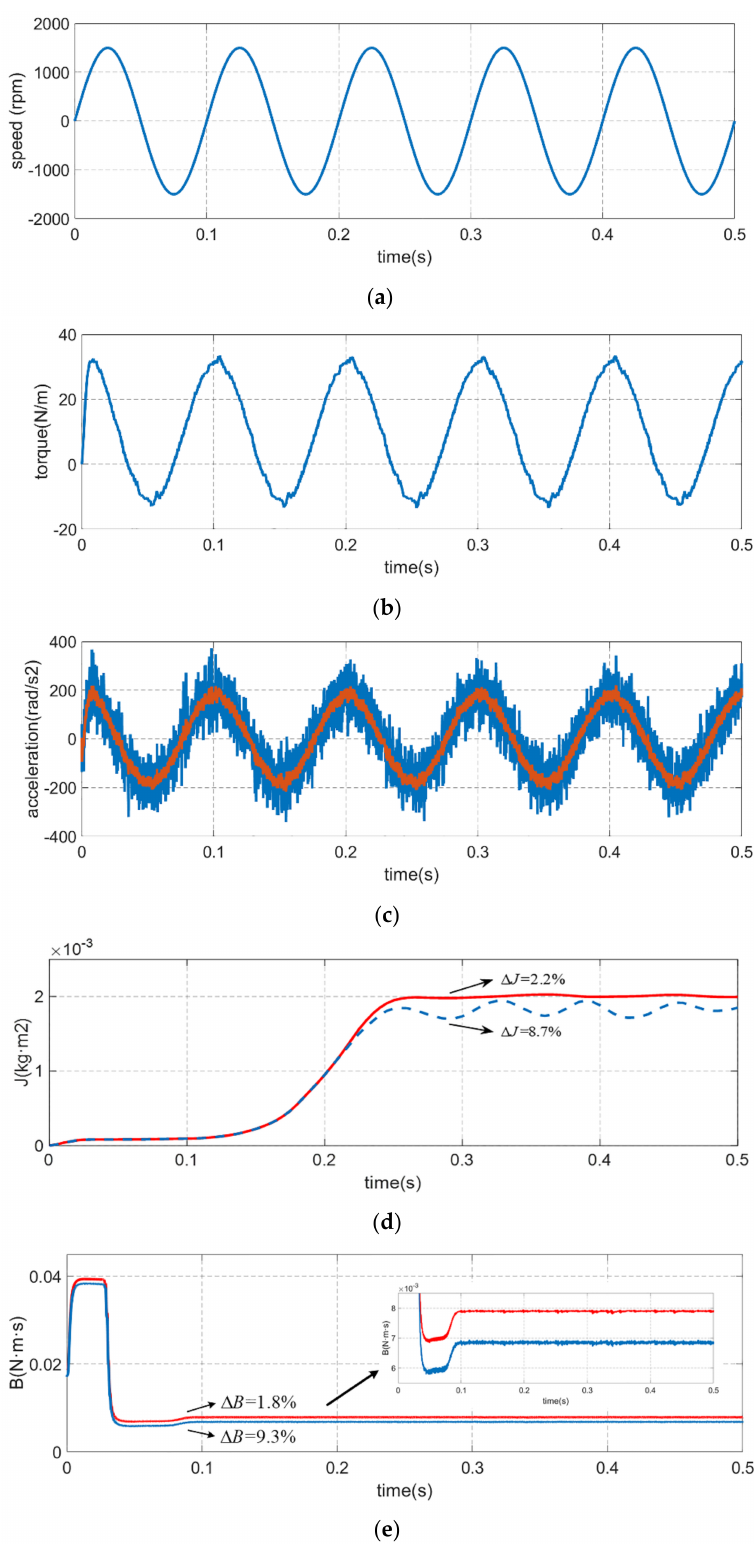
Figure 7. Comparison of inertia and friction coefficient identification results at the sinusoidal reference speed of 10 Hz, 1500 r/min which the blue line represents the classical integration method and red line represents the improved integration method. ( a ) Motor speed. ( b ) Electrical torque. ( c ) Acceleration. ( d ) Moment of inertia. ( e ) Viscous friction